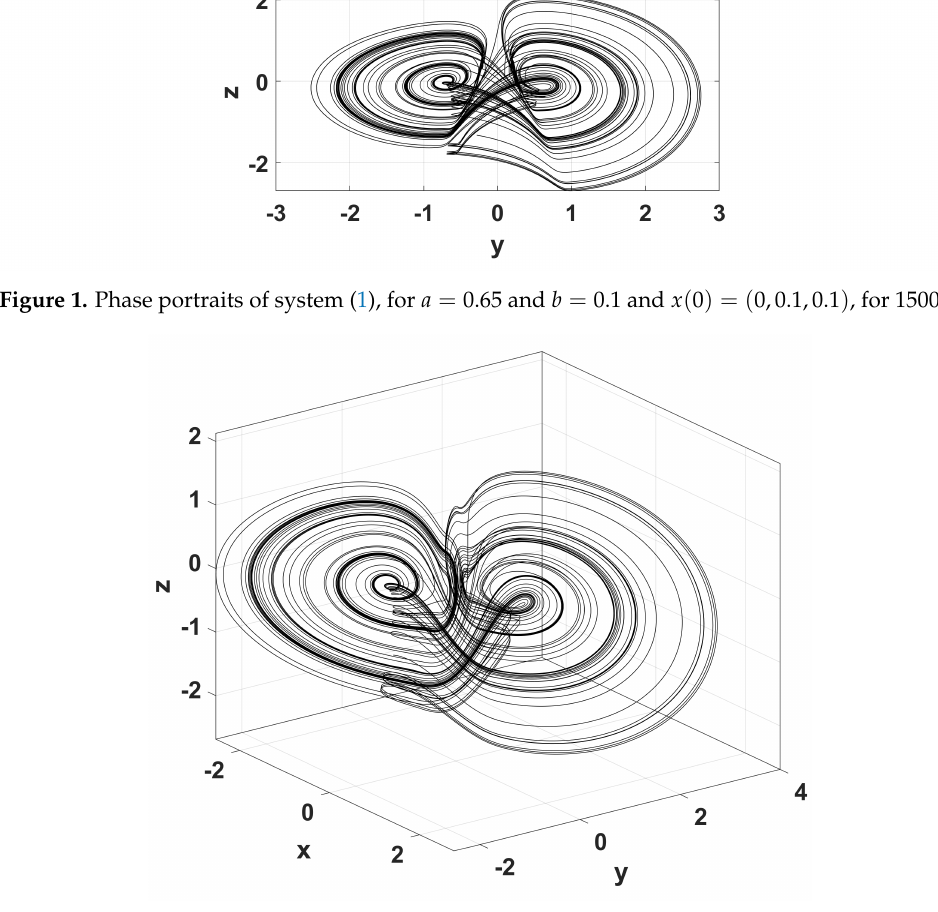
Figure 2. 3D chaotic attractor of system (1), for a = 0.65 and b = 0.1 and x ( 0 ) = ( 0,0.1,0.1 ) , for 1500